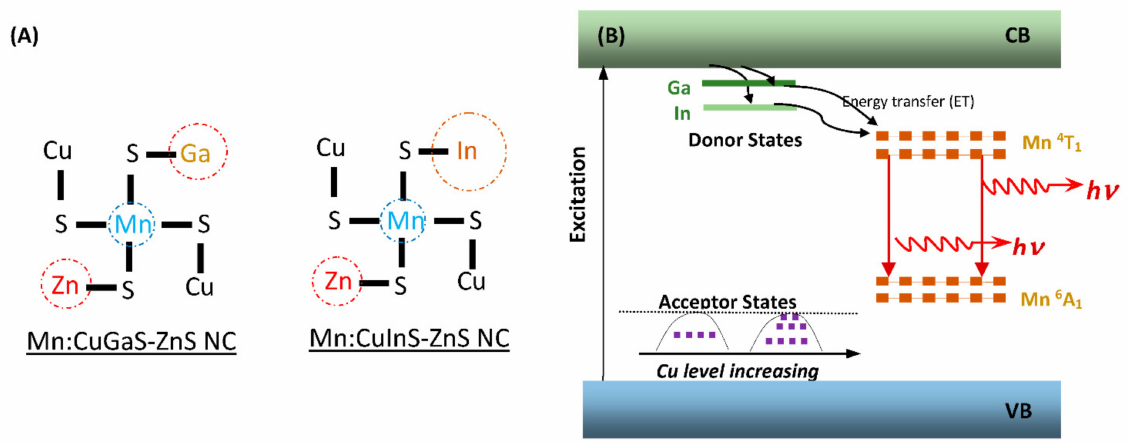
Figure 3. Illustration of possible fluorescence mechanisms of Mn-doped CuGaS-ZnS and CuInS-ZnS NCs. ( A ) Possible microenvironments surrounding Mn dopants (the coordinates of Mn with multiple ions in host NCs; the circle in illustration represents the relative atom size of Mn or Zn or Ga or In). ( B ) Possible energy-transfer (ET) pathways for Mn